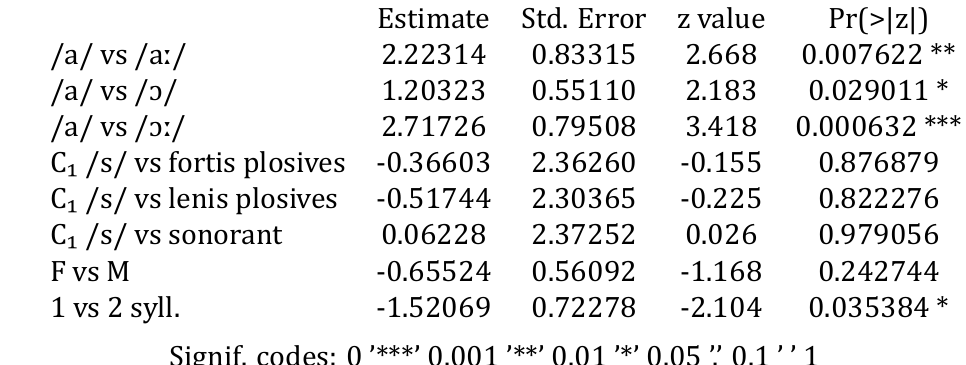
Table A.13: Post-aspiration duration (ms) of C₂ /s/ as a dependent variable